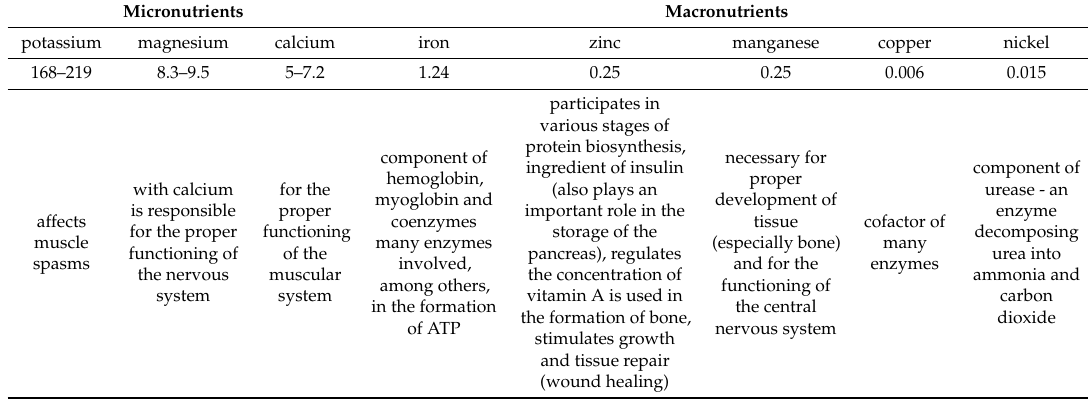
Table 3. Composition and significance of micronutrients and macronutrients in fruits (wt